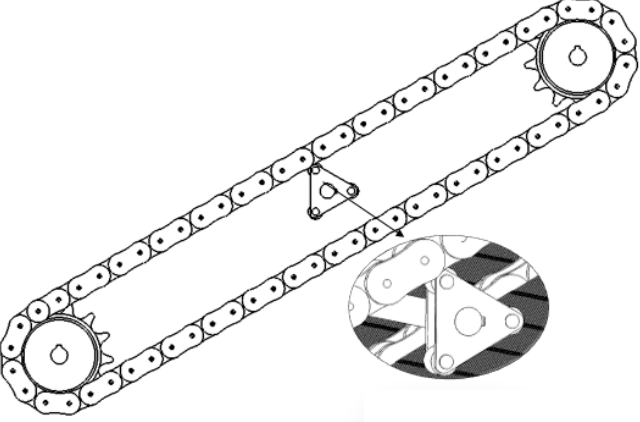
Figure 4. Schematic diagram of triangular vibrating wheel structure.